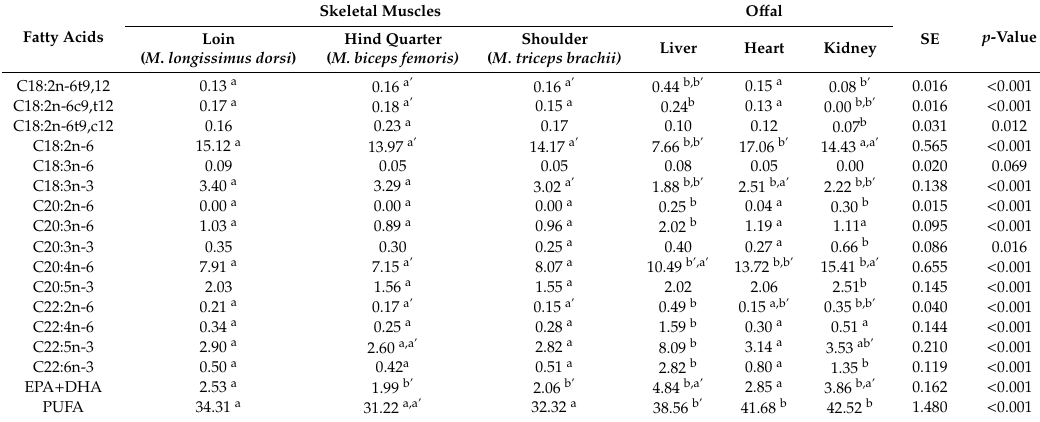
Table 3. E ff ect of tissue on polyunsaturated fatty acid (% of total fatty acid composition in lipids of red